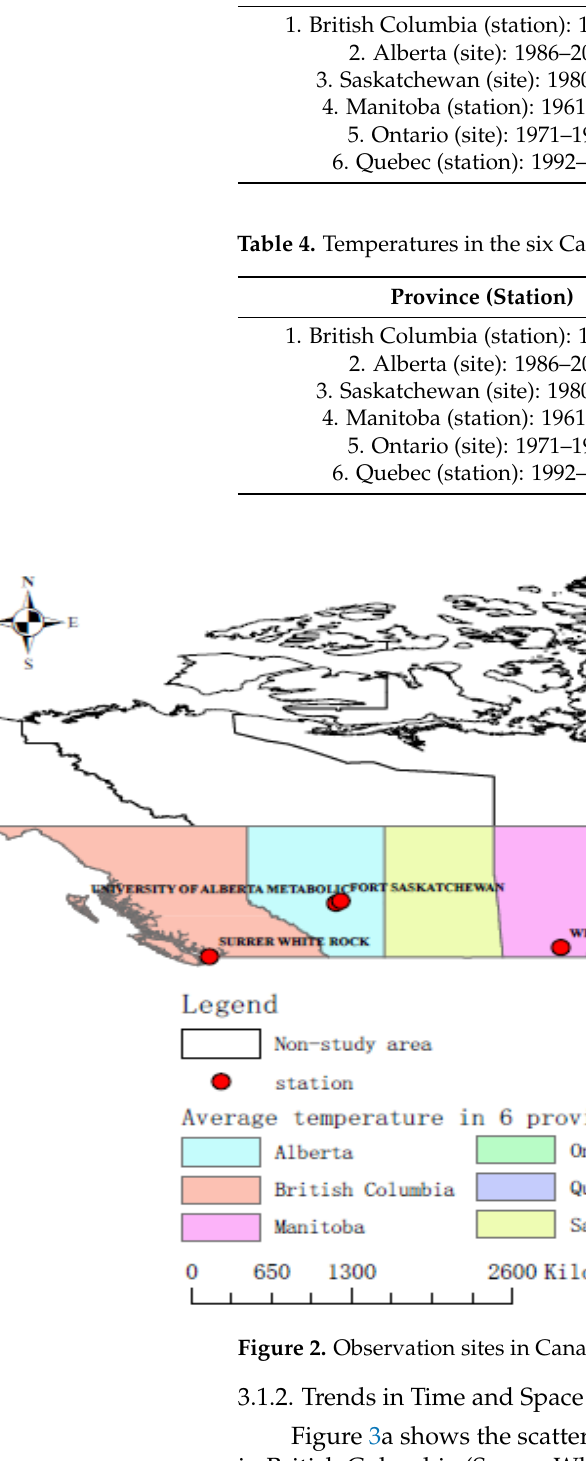
Table 3. Temporal trends of temperatures in six Canadian provinces (sites).